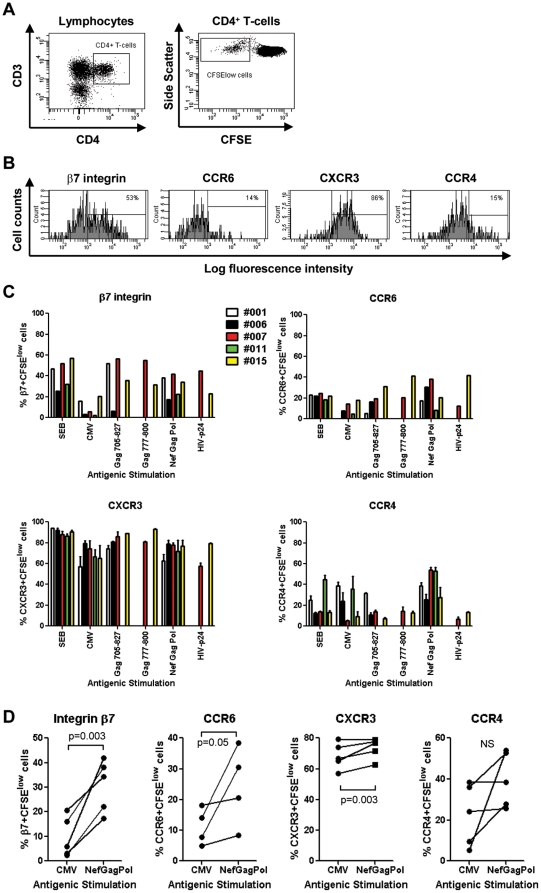
Preferential gut-homing potential of HIV-specific versus CMV-specific CD4+ T-cells.PBMC from SP subjects were loaded in CFSE (0.5 µM) and stimulated with different HIV Nef, Gag, Pol peptide pools (500 ng/ml), recombinant HIV-p24 (5 µg/ml), SEB (25 ng/ml), or the recombinant CMV-pp65 peptide pool (1 µg/ml) for 6 days at 37°C. Antigen-specific T-cells were identified as CFSElow cells, as previously described [52]. Cells were stained with a cocktail of fluorescence-conjugated CD3, CD4, integrin β7, CCR6, CXCR3, and CCR4 Abs and analyzed by polychromatic flow cytometry for (A) the frequency of CFSElowCD3+CD4+ T-cells (referred to as CD4+ T-cells) and (B–D) the expression of integrin β7, CCR6, CXCR3, and CCR4 on antigen-specific CFSElowCD4+ T-cells. (A–B) Shown are results from one donor (i.e., SP 007) generated upon stimulation of PBMC with HIV Gag705–827 peptide pool, representative of results generated with cells from five different donors. (C) Shown is the expression of the homing receptors on CFSElowCD4+ T-cells specific for SEB, CMV and different HIV peptide pools in five different SP subjects. (D) Shown is the homing molecule expression on matched CFSElowCD4+ T-cells specific for CMV versus HIVNefGagPol peptide pool in four-five different SP subjects. Paired T-test p-values are indicated in the figures.